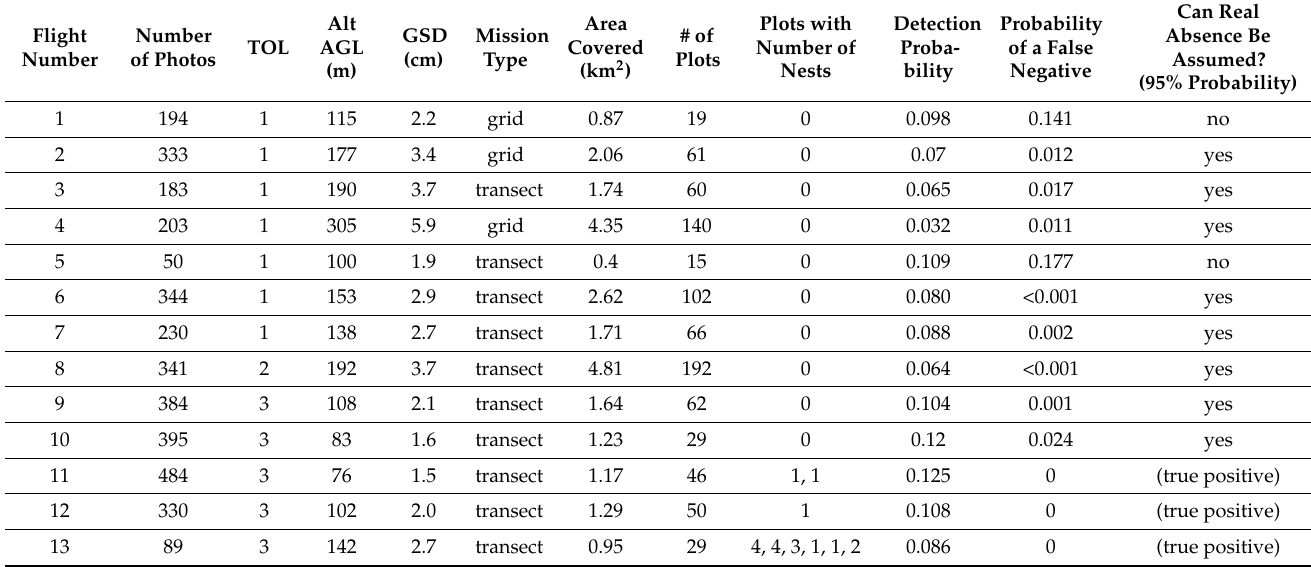
Table 2. Drone missions with flight characteristics and resulting probability to which real absence of chimpanzee nests can be